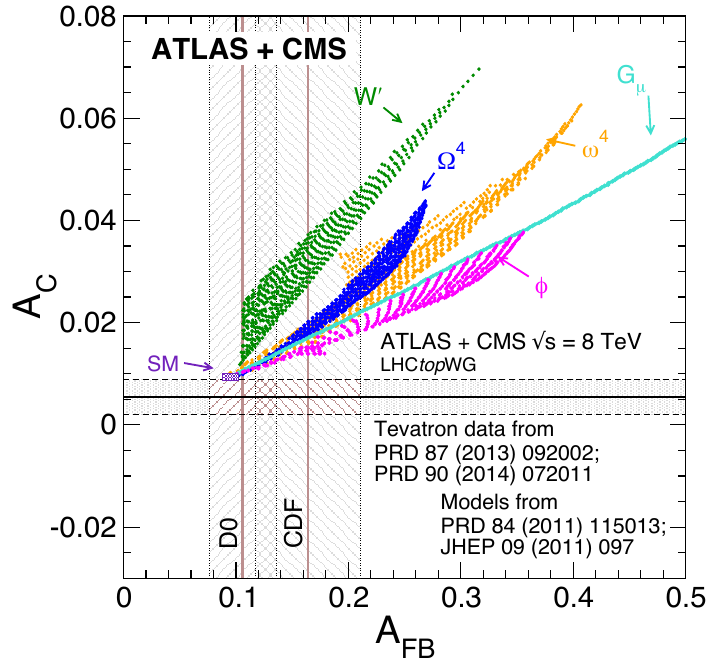
Figure 20. A t ¯ t - A FB plane with allowed parameter regions for various BSM scenarios. The LHC C combination is shown together with the latest Tevatron results from CDF and D0